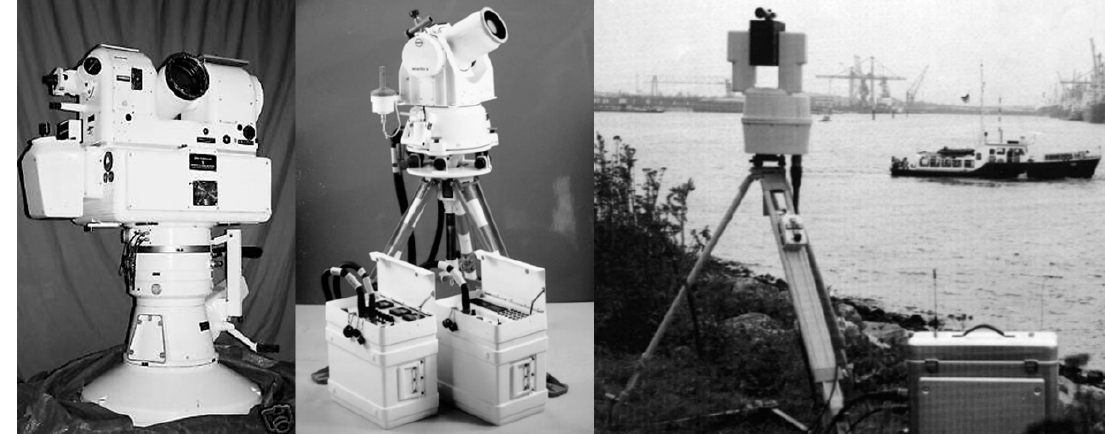
Figure 5. Contraves EOTS cinetheodolite ( left ) [23], AGA-Minilir cinetheodolite ( middle ) [24], and Krupp Atlas Polarfix ( right ) [22].